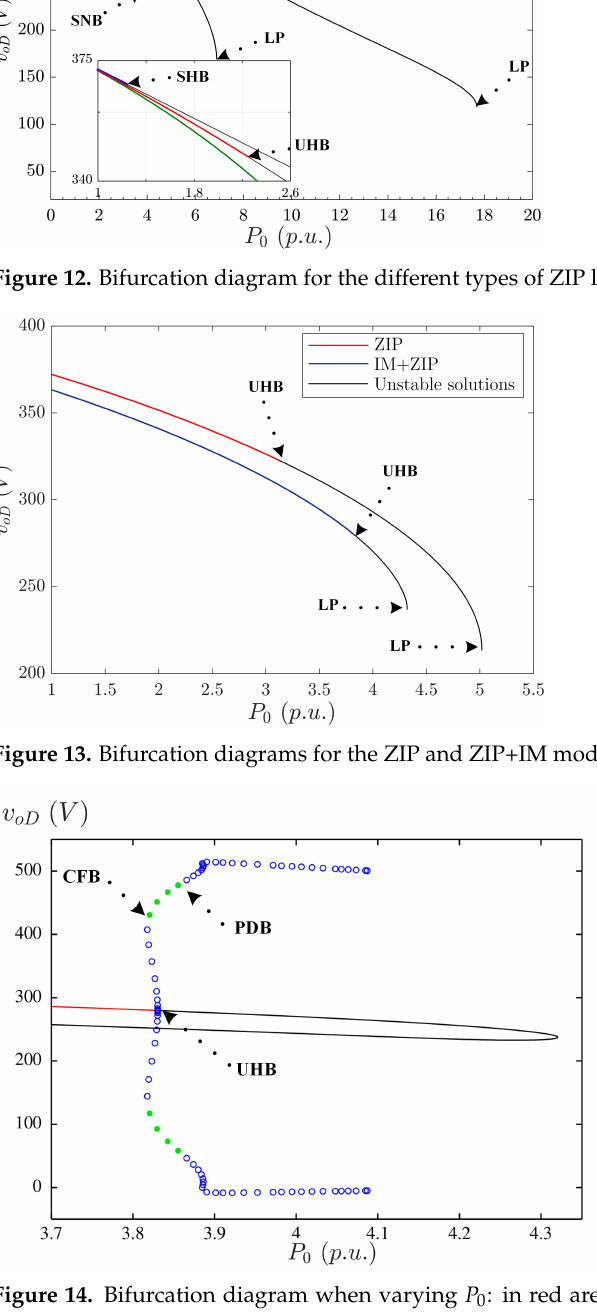
Figure 14. Bifurcation diagram when varying P 0 : in red are the stable solutions, in black are the unstable solutions, in green are the stable periodic solutions, and in blue are the unstable periodic